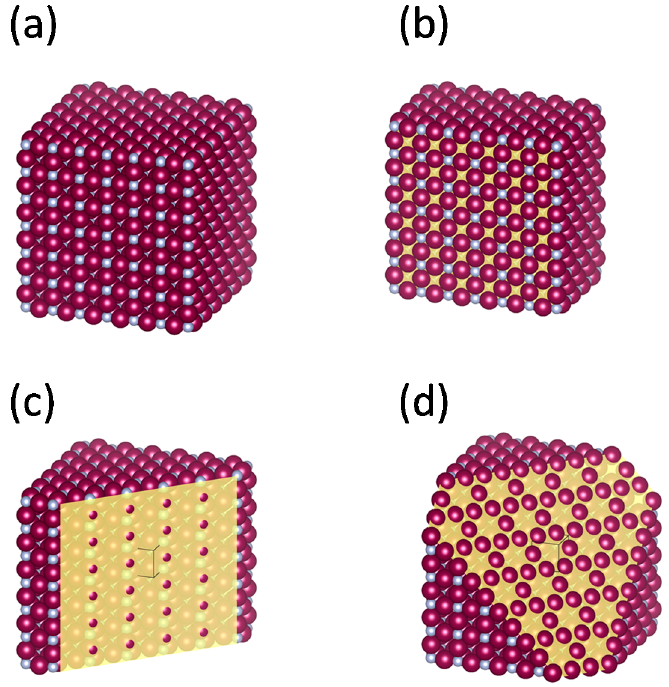
Figure 4. Images of ( a ) an original crystal structure of copper nitride; ( b ) a (100) plane; ( c ) a (110) plane; and ( d ) a (111) plane.